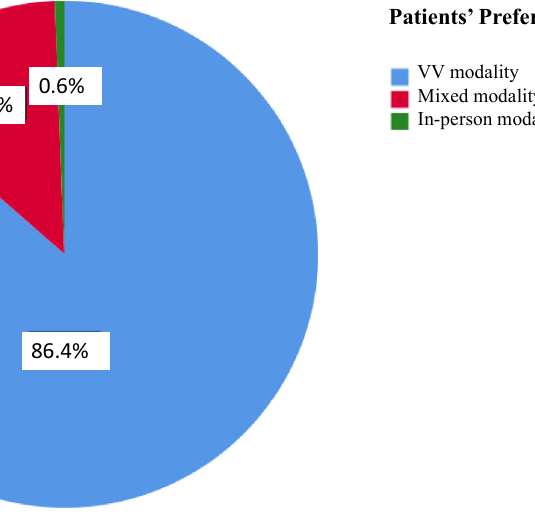
Figure 1. Patient preferences for each visit modality after the COVID-19 pandemic is over. Responses are expressed with different colors and percentages.